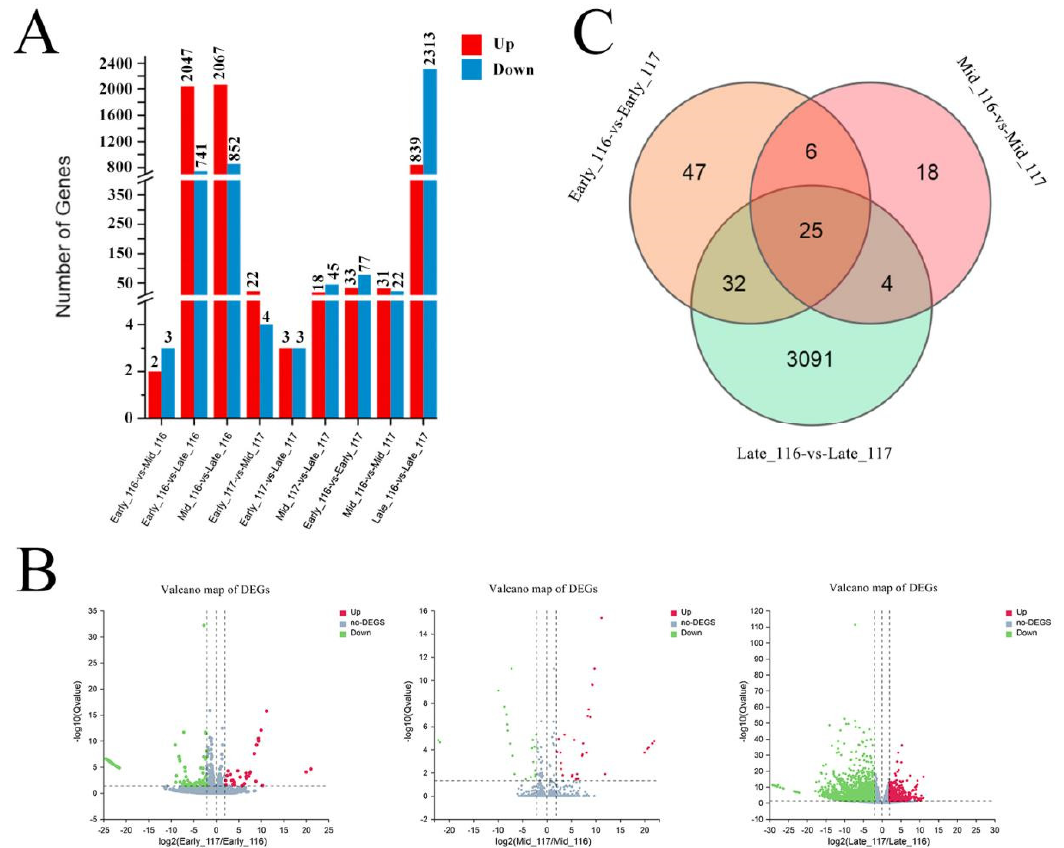
Figure 3. Statistics of the numbers of DEGs. ( A ) Statistical analysis of DEGs in different groups in different periods. ( B ) Volcano plot of DEGs between different groups. ( C ) Venn diagram statistics of comparisons between different groups.